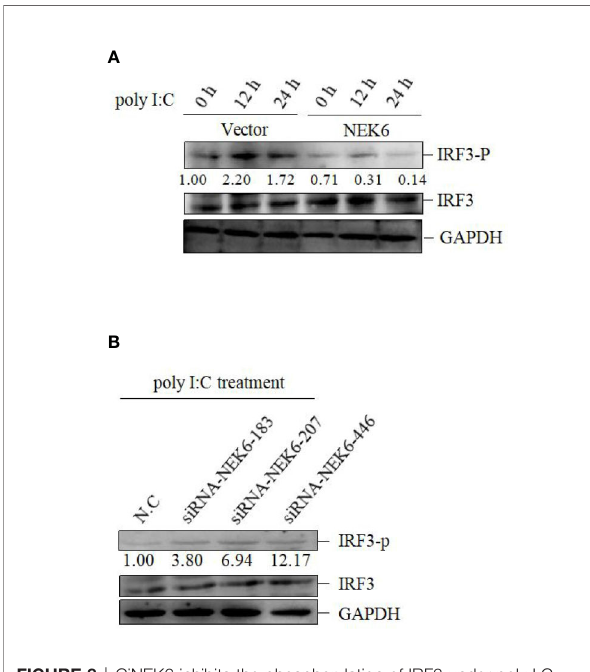
FIGURE 8 | CiNEK6 inhibits the phosphorylation of IRF3 under poly I:C treatment. CIK cells were transfected with 2 m g of basic-pcDNA3.1 or 2 m g of NEK6-pcDNA3.1. At 24 h post-transfection, the cells were treated with poly I: C and incubated for 0, 12, and 24 h (A) . CIK cells were transfected with 2 m g of siRNA-NEK6-183, 2 m g of siRNA-NEK6-207 or 2 m g of siRNA-NEK6-446 and 2 m g of N.C. At 24 h post-transfection, the cells were treated with poly I:C (B) . Phosphorylation of IRF3 (IRF3-p) was detected.